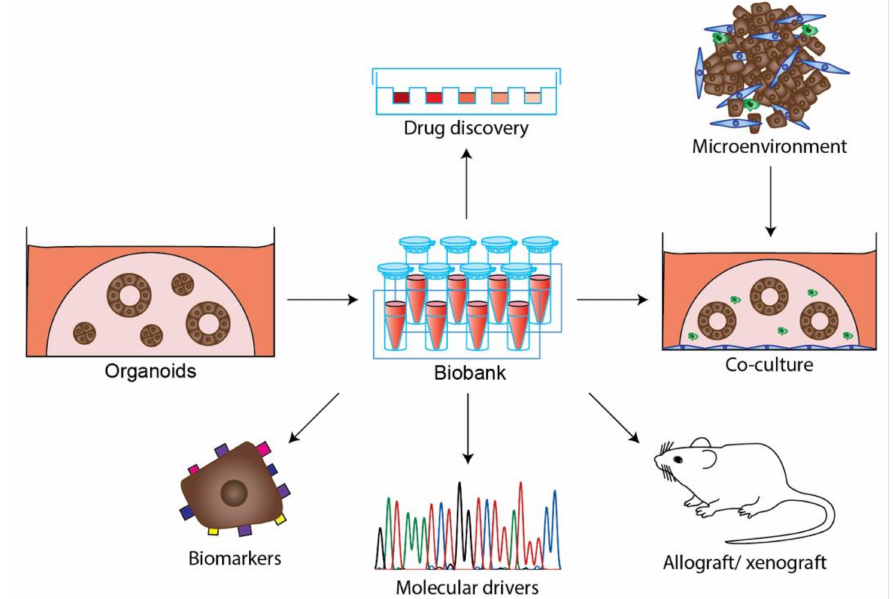
Figure 4. Diverse applications of PDAC tumor organoids. PDAC tumor organoids can be stored as biobanks and utilized to address multiple research questions, including drug discovery, identi- fication of biomarkers and molecular drivers. Organoids are emerging as model that integrate the microenvironment through coculture or transplantation in mice as allograft or